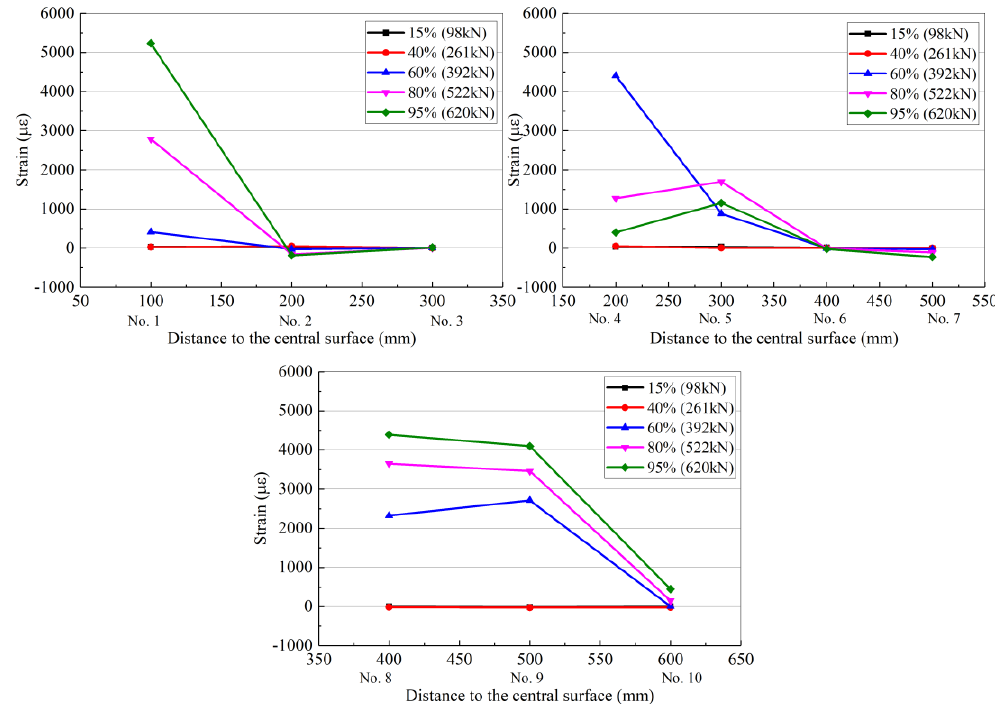
Figure 14. Strain distribution of flax fiber sheet for the RC-FRP5.